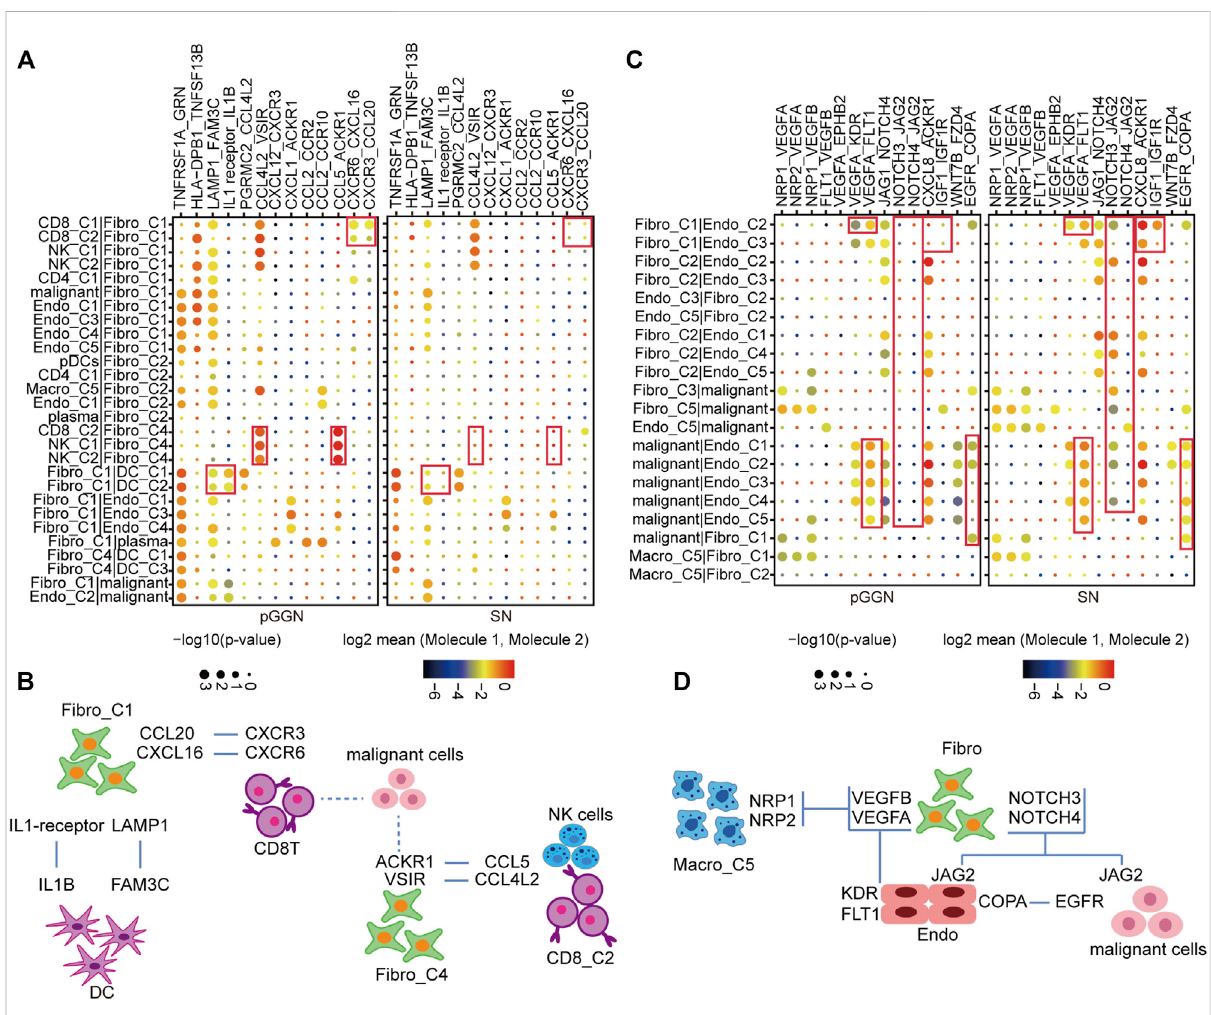
FIGURE 6 Constructing cell – cell interaction network during the progression of LUAD. (A) The dot plot depicting signi fi cant interactions of immune response among immune cells and stromal cells from tissues of pure GGN and SN. (B) The graphic model of the interactions among immune cells andstromal cell. (C) The dotplotdepicting signi fi cantoncogenicinteractionsamong malignant cellsandstromalcellsfrom tissuesofpureGGNand SN. (D) The graphic model of the oncogenic interactions among stromal cells and malignant cells. The colors of the dot represent the log- transformed expression levels, and the sizes of the bubbles indicate the signi fi cance of the interaction, as calculated by